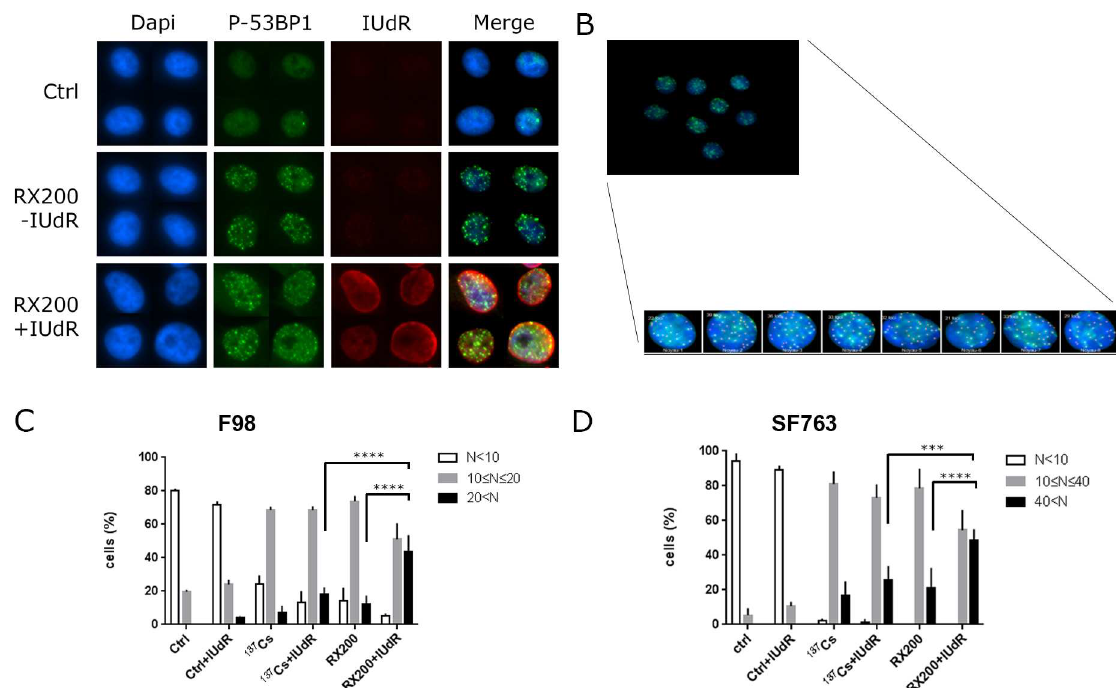
Fig 4. Analysis of DNA double-strand breaks foci. Cells were subjectedor not to IUdR pretreatment and then exposedto 4 Gy irradiationwith 137 Cs or RX200(72.5 keV) conditions. Immunostainingof 53BP1 and IUdR was performed 1 h post irradiation.(A) An exampleof immunostaining of radiation-induced 53BP1 foci (second column)and IUdR (third column), counterstaining with Dapi (first column)and merge are also shown. (B) An exampleof automatedcounting.Rangedistributionof foci per cell was determined in F98 (C) and in SF763 (D) cells (n =